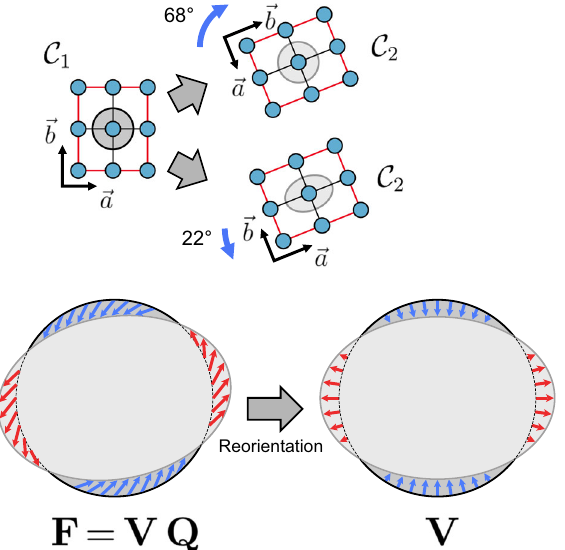
Fig. 1 Multiplicity of lattice mappings. Depiction of two possible orientation relationships between C 1 and C 2 . In one case, C 2 is rotated by − 68 ∘ without an accompanying strain, in the other case, C 2 is rotated by 22 ∘ and also strained. Bottom illustration depicts the de fi nition of the strain cost both before and after removal of rigid rotation. The strain cost is minimized at a unique value when the rigid rotation is